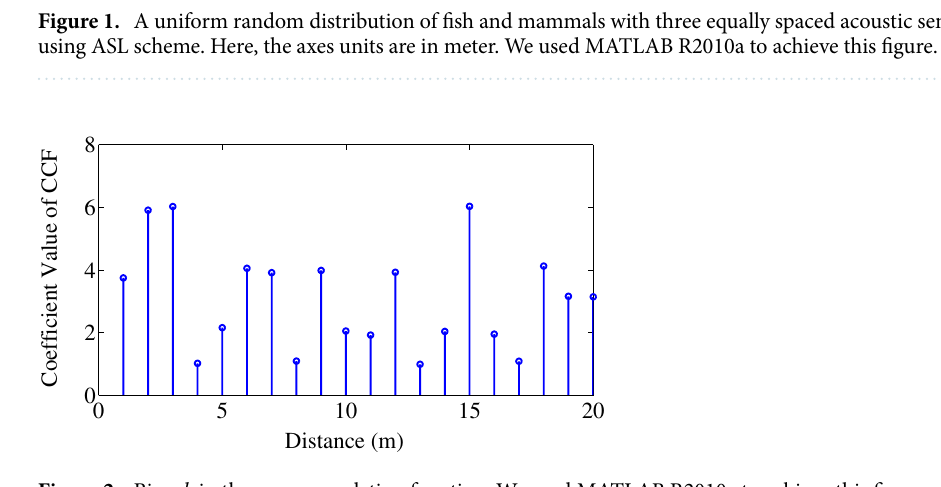
Figure 2. Bins, b in the cross-correlation function. We used MATLAB R2010a to achieve this